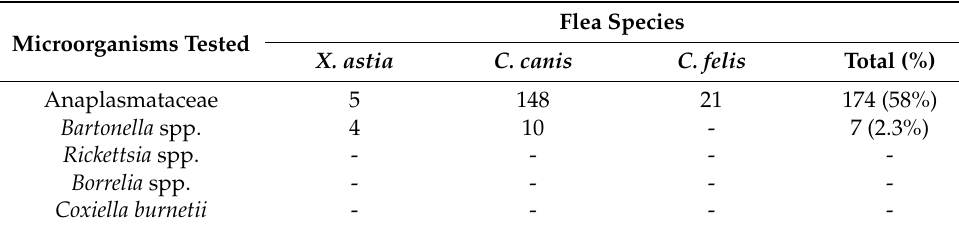
Table 3. Microorganisms detected using real-time PCR in fleas. Microorganisms